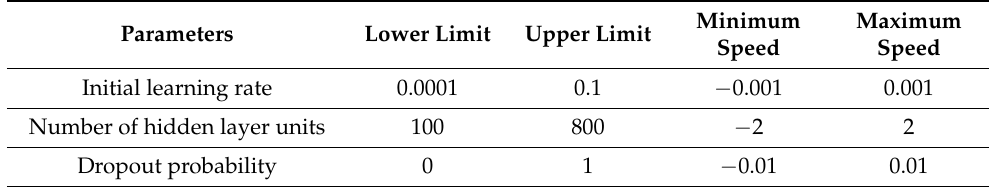
Table 4. PSO-LSTM optimization parameters.